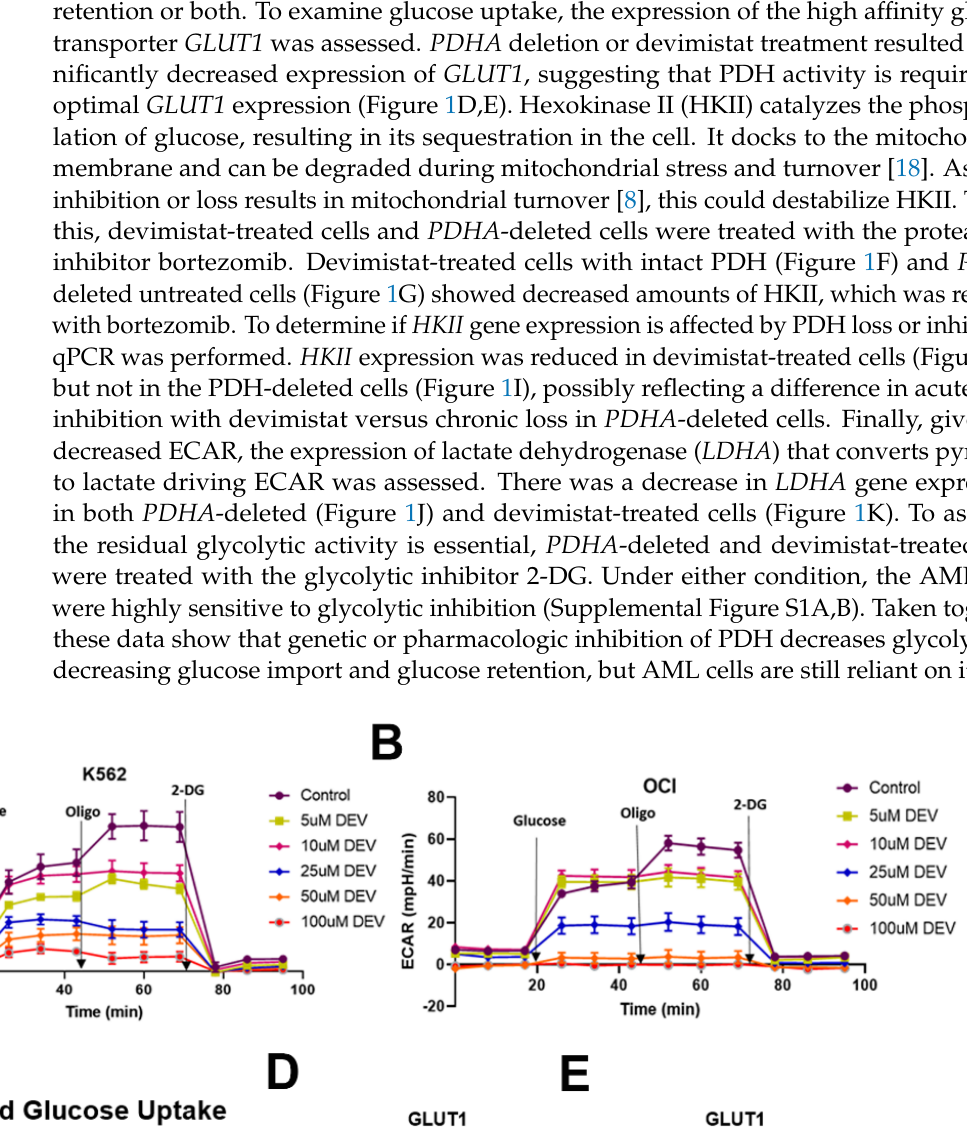
Figure 1. TCA cycle inhibition leads to decreased glycolysis glucose uptake and glucose retention. ( A , B ) Extracellular acidification rates (ECAR) following the indicated concentrations of devimistat on K662 ( A ) and OCI-AML3 ( B ) cells. Results are shown of three independent experiments, each done in triplicate. ( C ) Glucose uptake was assessed in ROSA control and PDH-deleted cells. The resulting data were normalized to ROSA control. ( D , E ) QPCR of GLUT1 in PDHA -deleted and con- trol ROSA26-deleted cells, and ( D ) MFL2 cells treated with the indicated amount of devimistat for 24 h ( E ). ( F ) Western blot of MFL2 cells treated with devimistat at 100 uM and/or bortezomib at 1 nM for 24 h. Relative densitometry readings below actin. ( G ) Western blot of ROSA and PDH KO cells treated with bortezomib at 1 or 5 nM for 24 h. Relative densitometry readings below actin. ( H ) QPCR analysis of Hexokinase II in MFL2 cells treated with the indicated amount of devimistat for 24 h. ( I ) QPCR analysis of Hexokinase II in ROSA control and PDH-deleted cells. ( J ) QPCR analysis of LDHA in ROSA control and PDH-deleted cells, and ( K ) MFL2 cells treated with the indicated amount of devimistat for 24 h. **** = p -value less than or equal to 0.0001; ** = p -value less than or equal to 0.01; * = p -value less than or equal to 0.05; ns = nonsignificant. The uncropped blots are shown in File S1. 3.2. Gluconeogenesis Is a Source of Resistance to Devimistat PDH inhibition leads to decreased glucose uptake, retention and glycolysis, likely making essential glycolytic intermediates limiting. During glucose deprivation, cancer